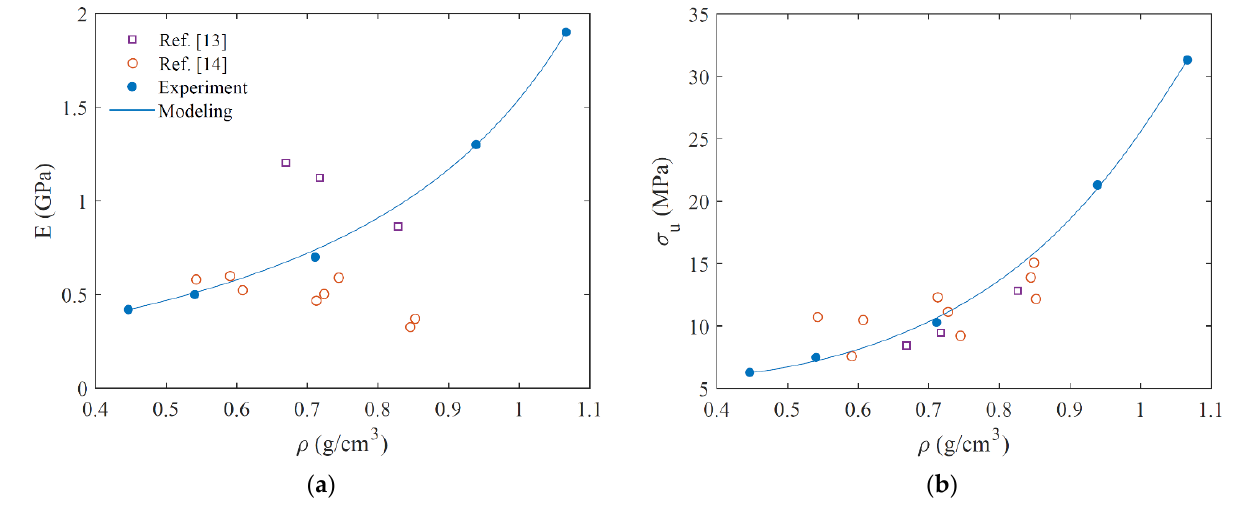
Figure 6. Young modulus ( a ) and ultimate strength ( b ) of 3D-printed foam material with different densities.